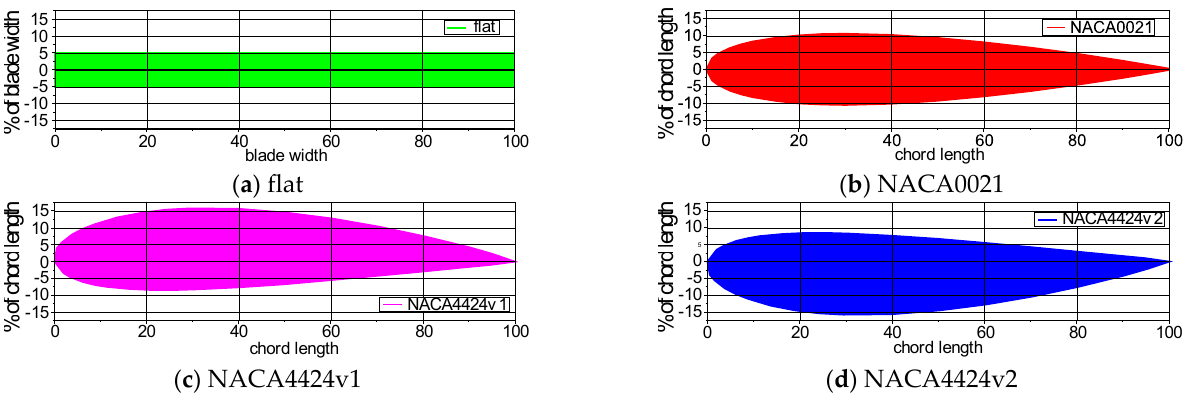
Figure 3. Blade profiles: ( a ) rectangular (flat), ( b ) symmetrical NACA0021, ( c , d ) asymmetrical NACA4424.